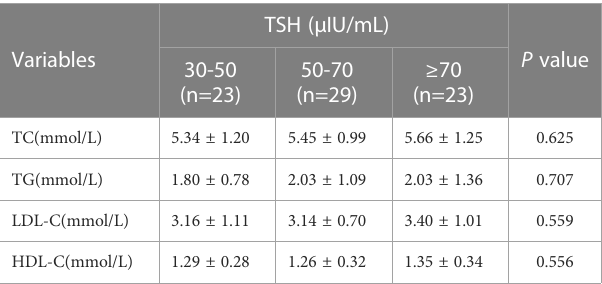
TABLE 3 Serum lipid levels with different TSH subgroups.